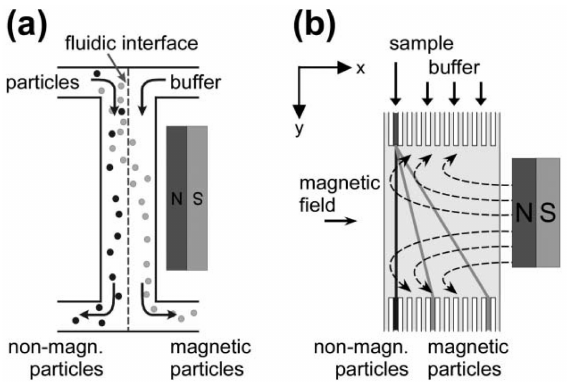
Figure 7. Magnetic separation from a continuous flow: applying a magnetic field perpendicular to the direction of the fluidic flow results in a deflection of magnetic particles or magnetically labeled molecules. ( a ) Separation of non-magnetic particles from magnetic particles via two outlets; and ( b ) system with multiple outlets (reprinted with permission from [6]).